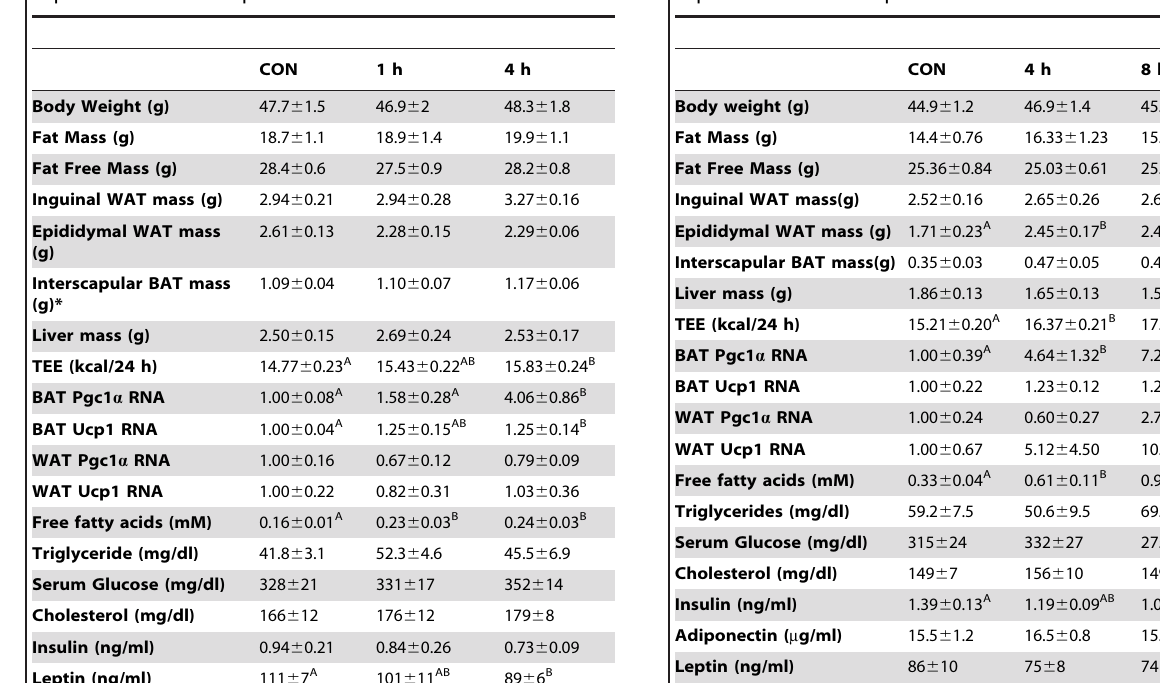
Table 2. ICE # 2, effect of 4 hours and 8 hours of cold exposure three times per